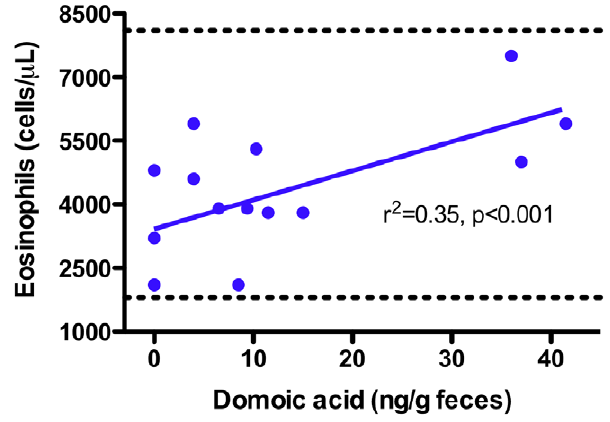
Figure 6. Domoic acid concentration in feces versus eosinophil count. Dashed green lines represent published reference thresholds [45]. Regression analysis indicated a statistically significant increase in eosinophil count (p , 0.001), although none of the measured values were outside of established reference thresholds. doi:10.1371/journal.pone.0017394.g006 PLoS ONE |